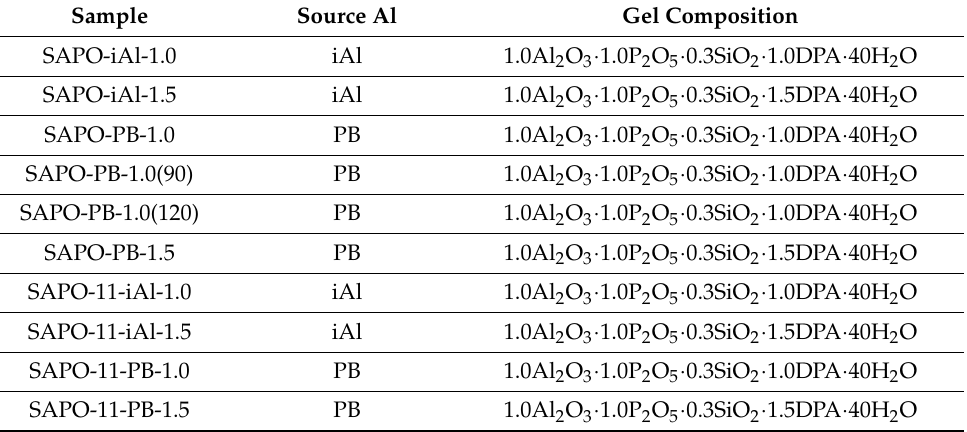
Table 4. Conventional designation of silicoaluminophosphate gels of various chemical composition and crystallization